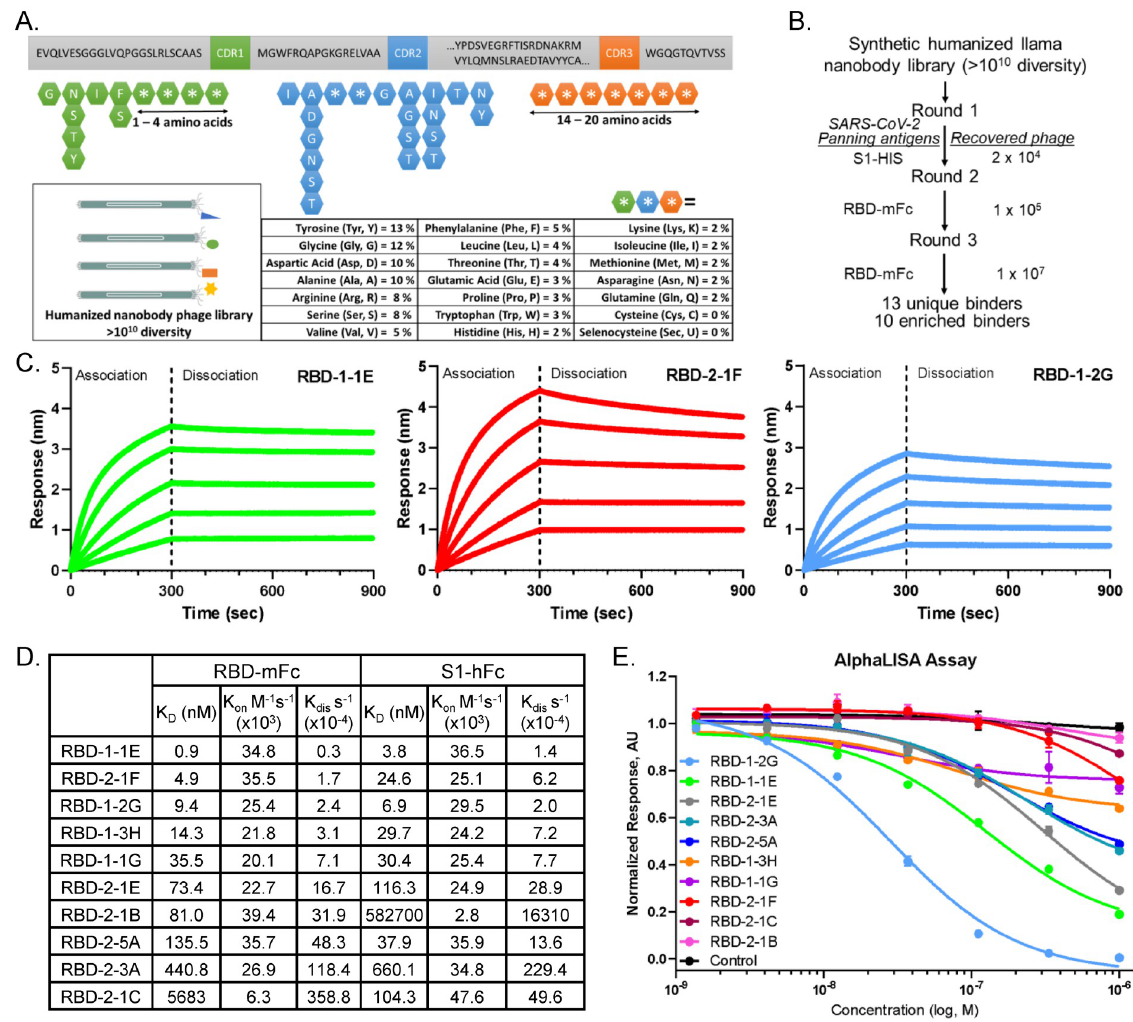
Fig 1. Discovery of anti-SARS-CoV-2 Spike RBD nanobodies that block interactions with ACE2. (A) Construction of a synthetic humanized llama nanobody library. (B) Selection strategy for identification of anti-RBD nanobodies using phage panning. (C) Bio-layer interferometry binding profiles of RBD-1-1E, RBD-2-1F and RBD-1-2G against RBD-mFc (200 nM to 12.5 nM, 1:2 dilution). (D) Association (k on ) and dissociation (k off ) rate constants and equilibrium dissociation constants (K D ) of nanobodies binding to RBD-mFc and S1-hFc. Global fit calculations for RBD-1-1E, RBD-2-1F, and RBD-1-2G used (200 nM to 12.5 nM), with all others using 200 nM to 50 nM. (E) Nanobodies inhibition of RBD-Fc binding to ACE2-Avi using AlphaLISA.